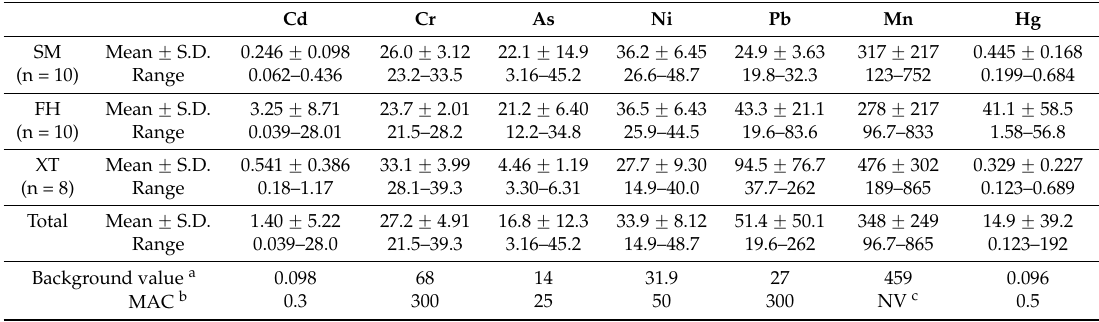
Table 3. Concentrations (mean ˘ standard deviation, mg/kg) of seven elements in soil from three districts in Hunan